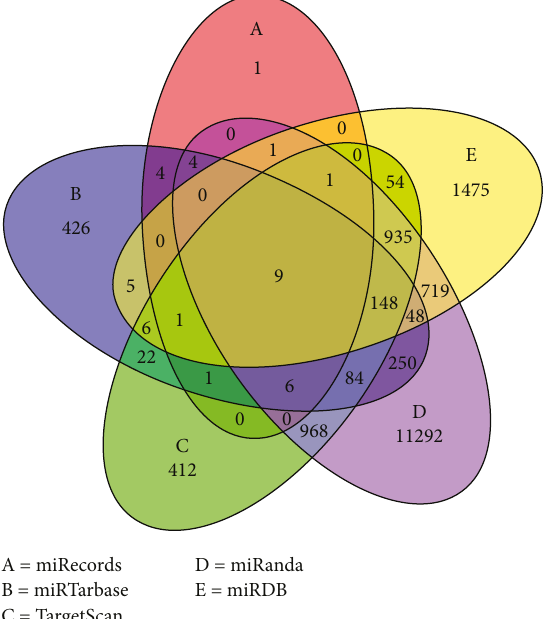
Figure 5: Venn diagram displaying the predicted target genes of the di ff erently expressed miRNAs. The targets were obtained from the following 5 databases: miRecords (red), miRTarBase (blue), TargetScan (green), miRanda (purple), and miRDB (yellow). The overlaps indicate genes that were predicted by two or more databases.